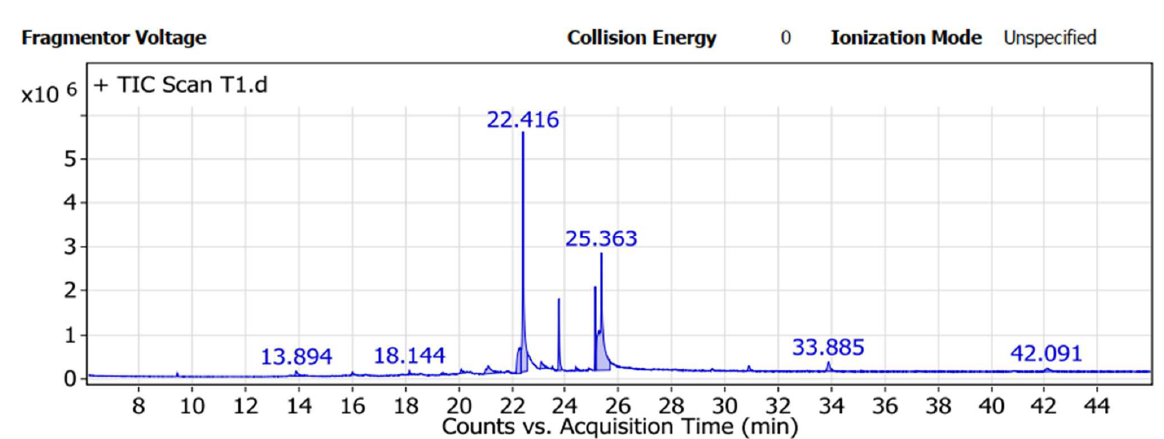
Figure 6. GC-MS of filtrate of Trichoderma asperellum ZNW.